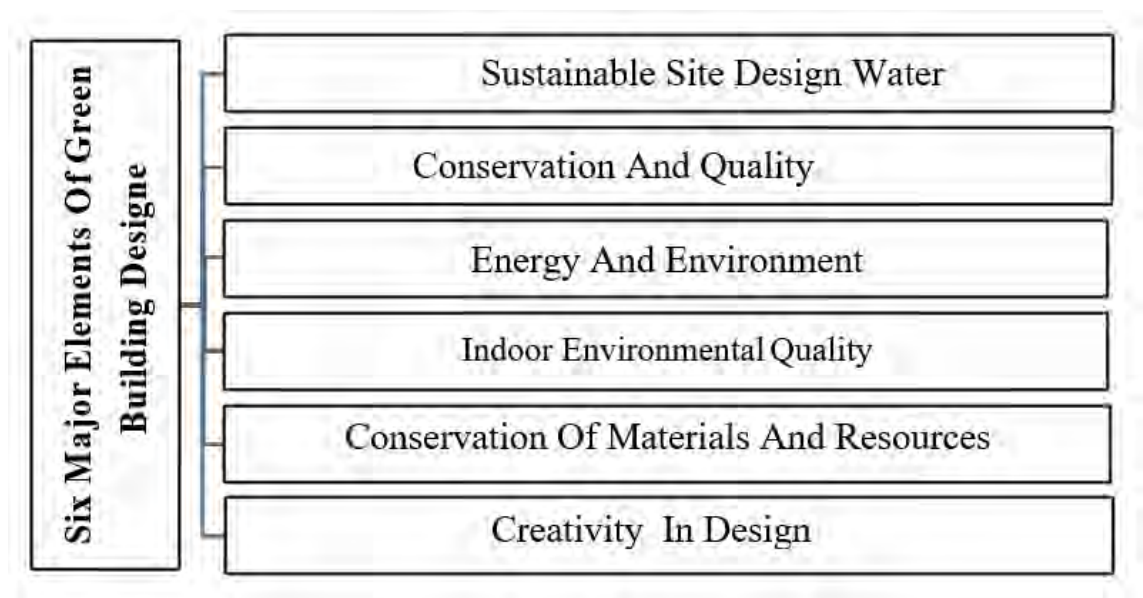
Figure 1. Six Major Elements of Green Building